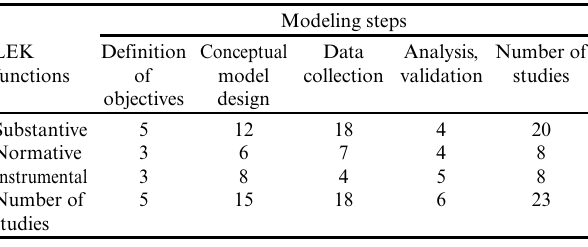
Table 1 . Number of published studies claiming